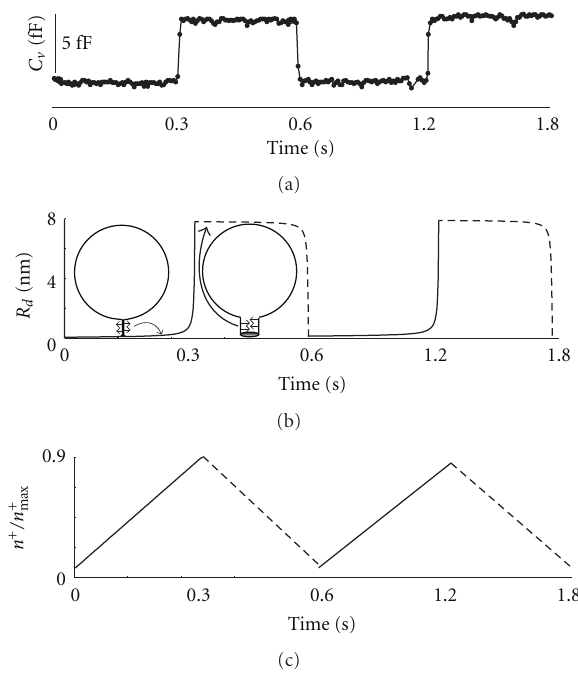
Figure 5: The e ff ects of changes in cation concentration in the vesicle on the rhythmic opening and closure of the fusion pore. Cell- attached patch-clamp recordings (capacitance trace) following the application of a cAMP-increasing agent demonstrate fast rhythmic opening and closure of an individual fusion pore (a). Note that the capacitance change between closed and open fusion pore states is about 5fF. Numerical simulations demonstrating the time dynamics of the pore radius ( R d ) (b). Note the abrupt opening and closure of the fusion pore. The membrane force derived from the membrane bending energy is exerted along the perpendicular direc- tion to the major axis of the fusion pore (see arrows). The cation concentration dynamics includes the e ffl ux through the fusion pore and the influx through the vesicle membrane